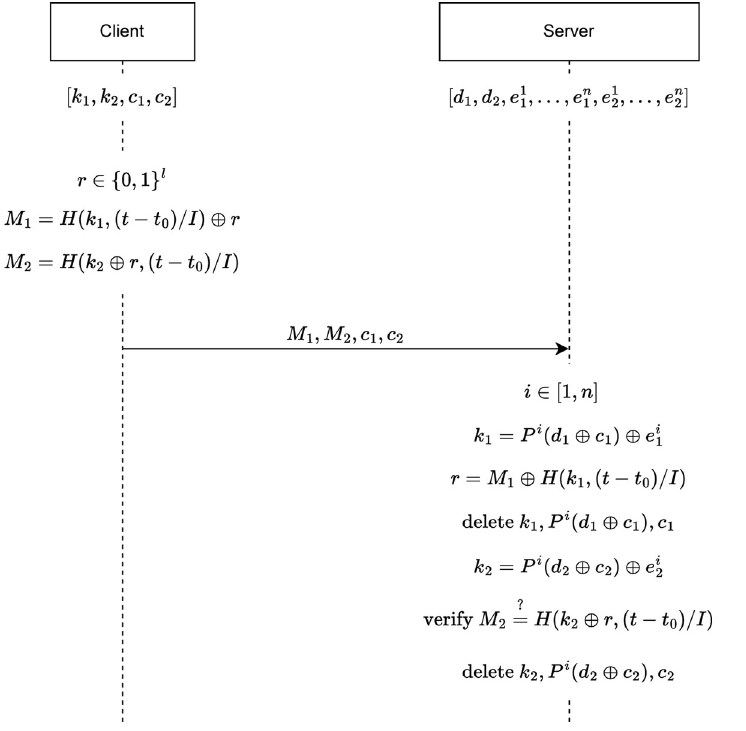
Fig 2. P/Key: Authentication